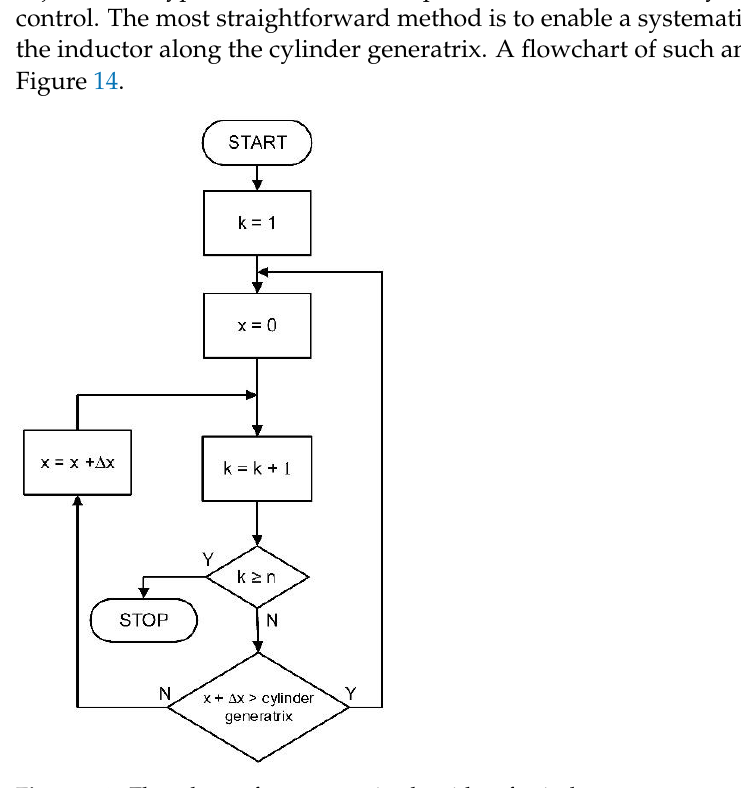
Figure 13. Block diagram of a two-circuit temperature control system, where x — position along the forming cylinder, Tset(x) — temperature profile setpoint, T(x) — temperature profile, P(x) — heat power profile.